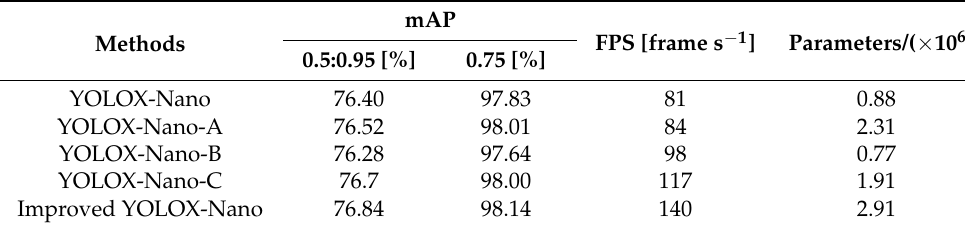
Table 1. Ablation